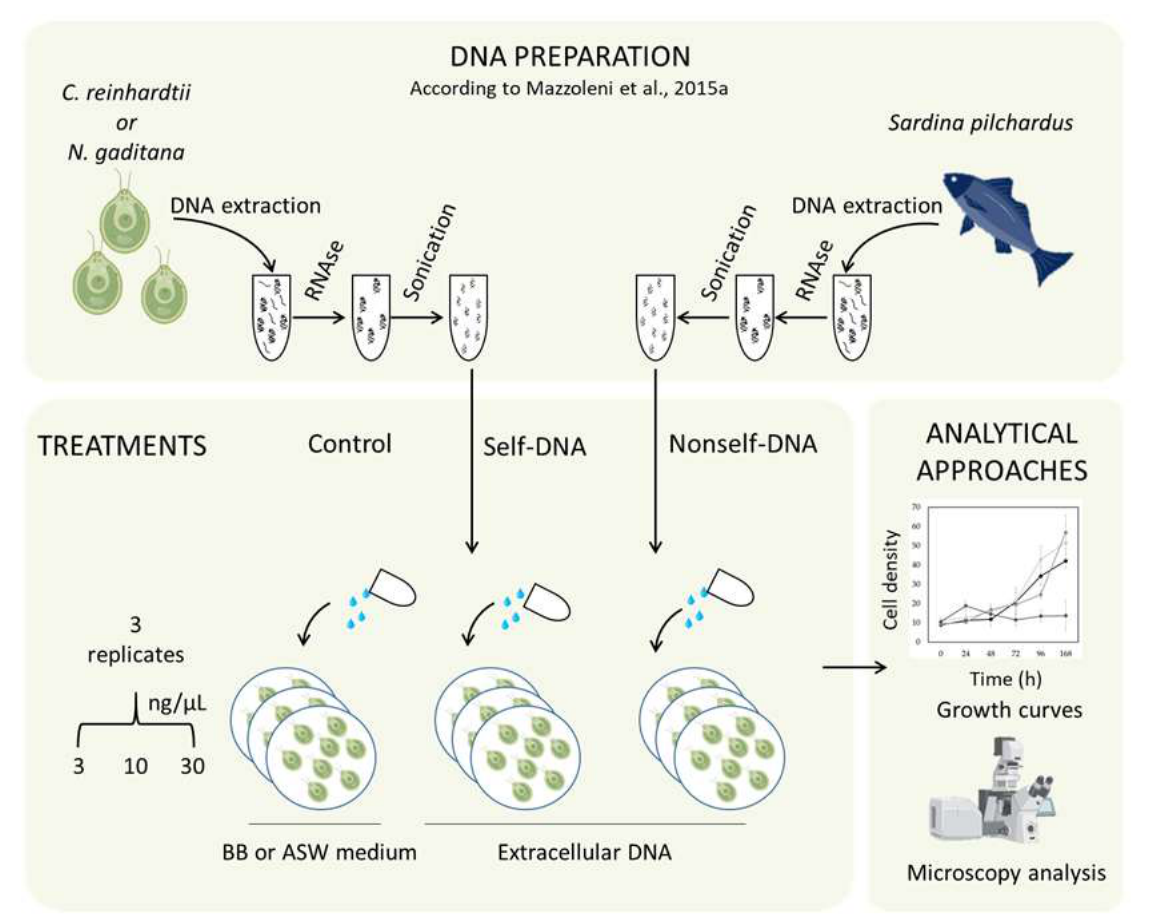
Figure 6. Schematic overview of the experimental design. DNA PREPARATION: extraction, RNase treatment, and sonication of DNA from C. reinhardtii or N. gaditana (self-DNA) and from Sardina pilchardus (nonself-DNA), according to Mazzoleni et al., 2015a [86]. TREATMENTS: the exposure of both microalgae to three different concentrations (3, 10, and 30 ng/µL) was performed in triplicate. ANALYTICAL APPROACHES: Growth curves of microalgae and microscopy analyses were performed to evaluate the effects of both exDNA. Legend: BB medium is Bold-Basal medium and ASW is Artificial Seawater Medium.